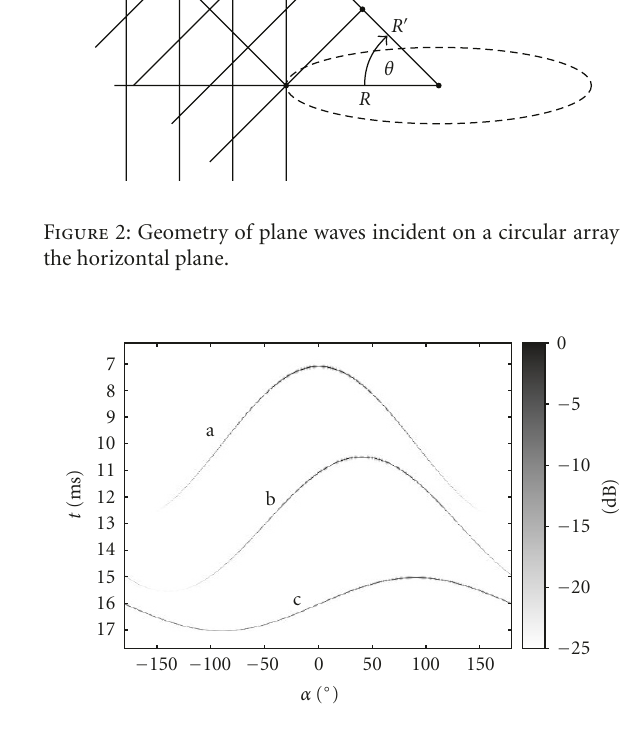
Figure 3: Arrival times as a function of microphone position on a circular array for three plane waves with (a) ϕ = 0 ◦ , θ = 0 ◦ , τ = 10 milliseconds, (b) ϕ = 40 ◦ , θ = 30 ◦ , τ = 13milliseconds, and ϕ = 90 ◦ , θ = 70 ◦ , τ = 16 milliseconds (c) for an array with radius R = 1